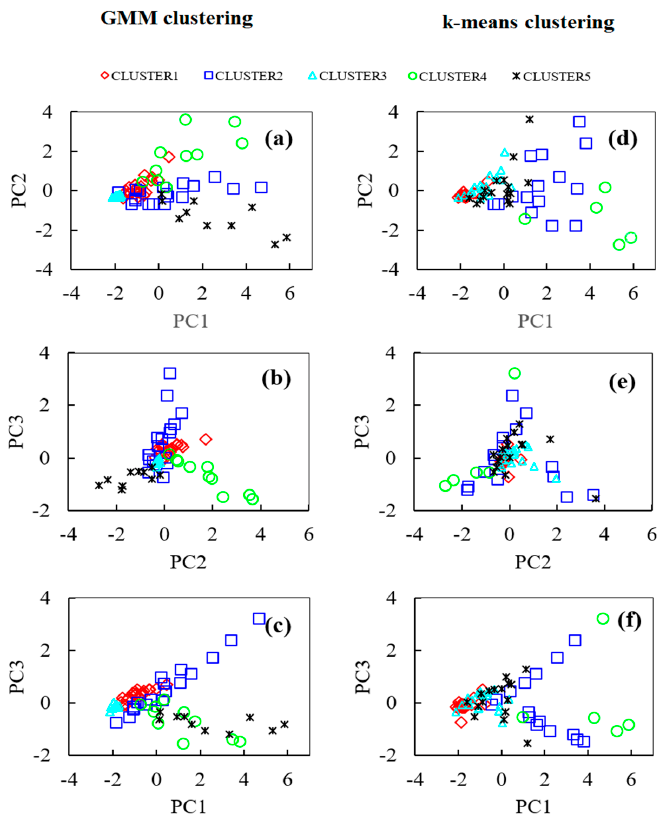
Figure 3. The results of GMM clustering and k-means clustering in principal component (PC) spaces. ( a ) GMM, in PC1-PC2 space; ( b ) GMM, in PC2-PC3 space; ( c ) GMM, in PC1-PC3 space; ( d ) k-means, in PC1-PC2 space; ( e ) k-means, in PC2-PC3 space; ( f ) k-means, in PC1-PC3 space.